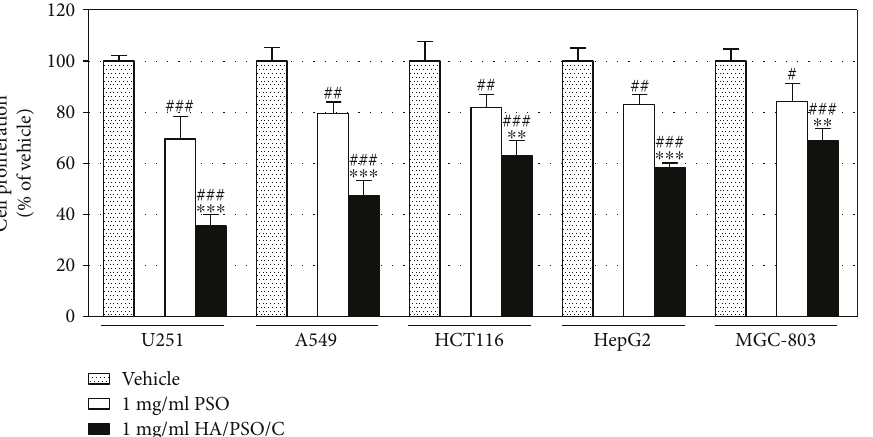
Figure 5: Cytotoxicity of HA/PSO/C NPs on various cancer cells. Anticancer e ff ect of HA/PSO/C NPs or free PSO on U251, A549, HCT116, HepG2, and MGC-803 with 1mg/ml for 24h, measured by the MTT assay. Percentages of cell proliferation were normalized by optical density values of the vehicle group (as 100%). Data are shown as means ± SD ( n = 5 ). ∗∗ denotes P < 0 01 , and ∗∗ ∗ denotes P < 0 001 ; comparisons were performed between groups of HA/PSO/C NPs and PSO. # denotes P < 0 05 ## denotes P < 0 01 , and ### denotes P < 0 001 ; comparisons were performed against the vehicle group.